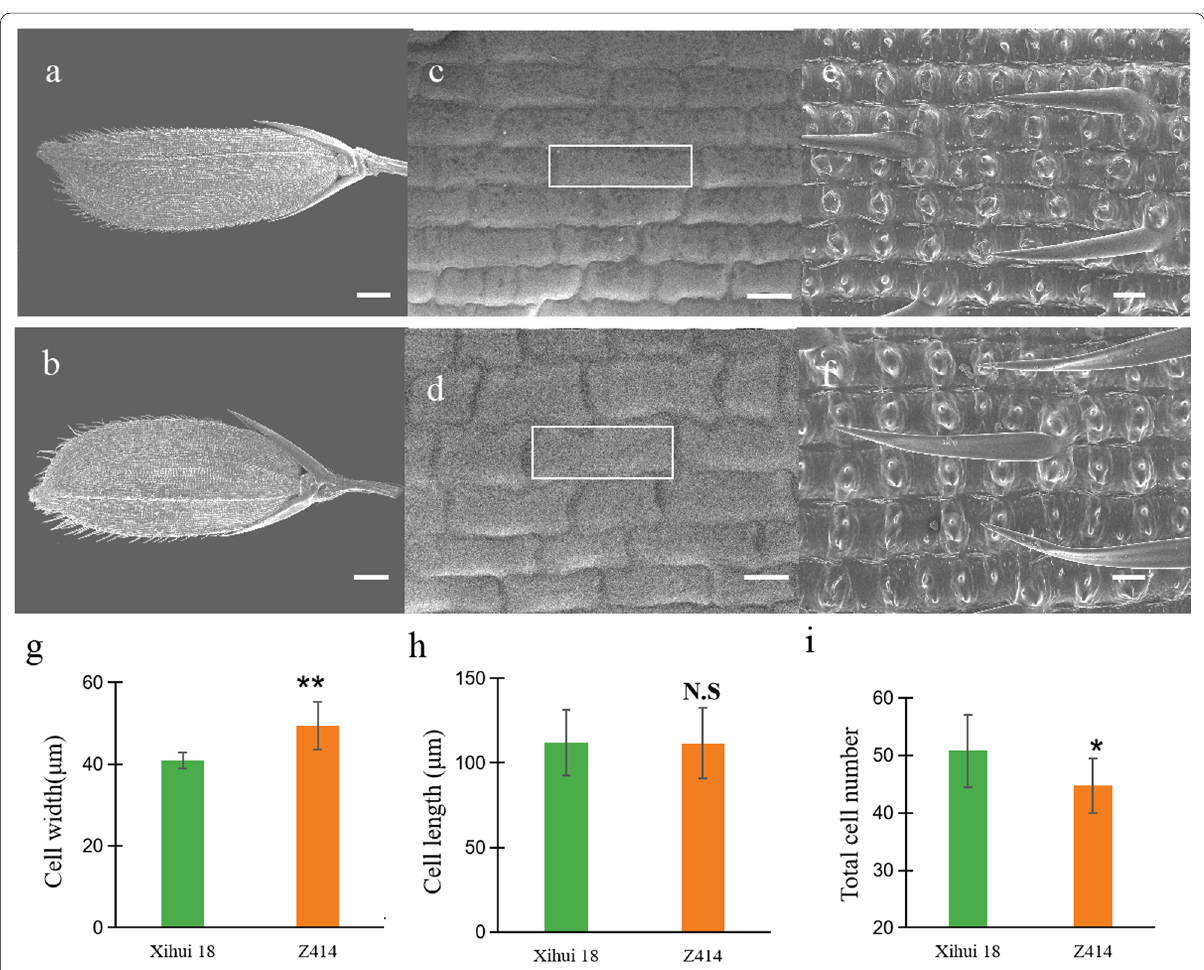
Fig. 3 Scanning electron microscopy of Xihui 18 and Z414 glumes. a – f Scanning electron micrographs of the lemma ( a , b ), inner epidermis ( c , d ) and outer epidermis ( e , f ) of Xihui 18 ( a , c , e ) and Z414 ( b , d , f ) glumes. g , h , i show cell width, cell length, and total number of cells in the outer